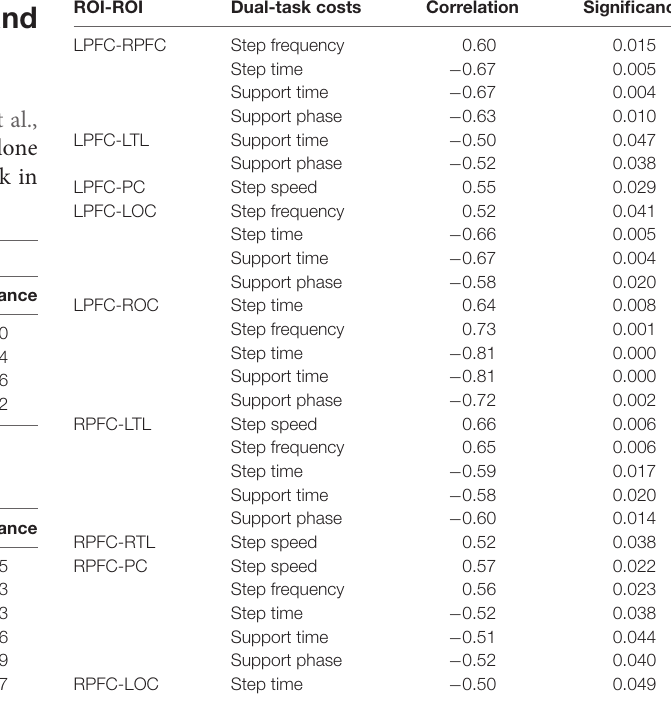
TABLE 6 | The analysis of dual-task costs and ROI of EG during Task